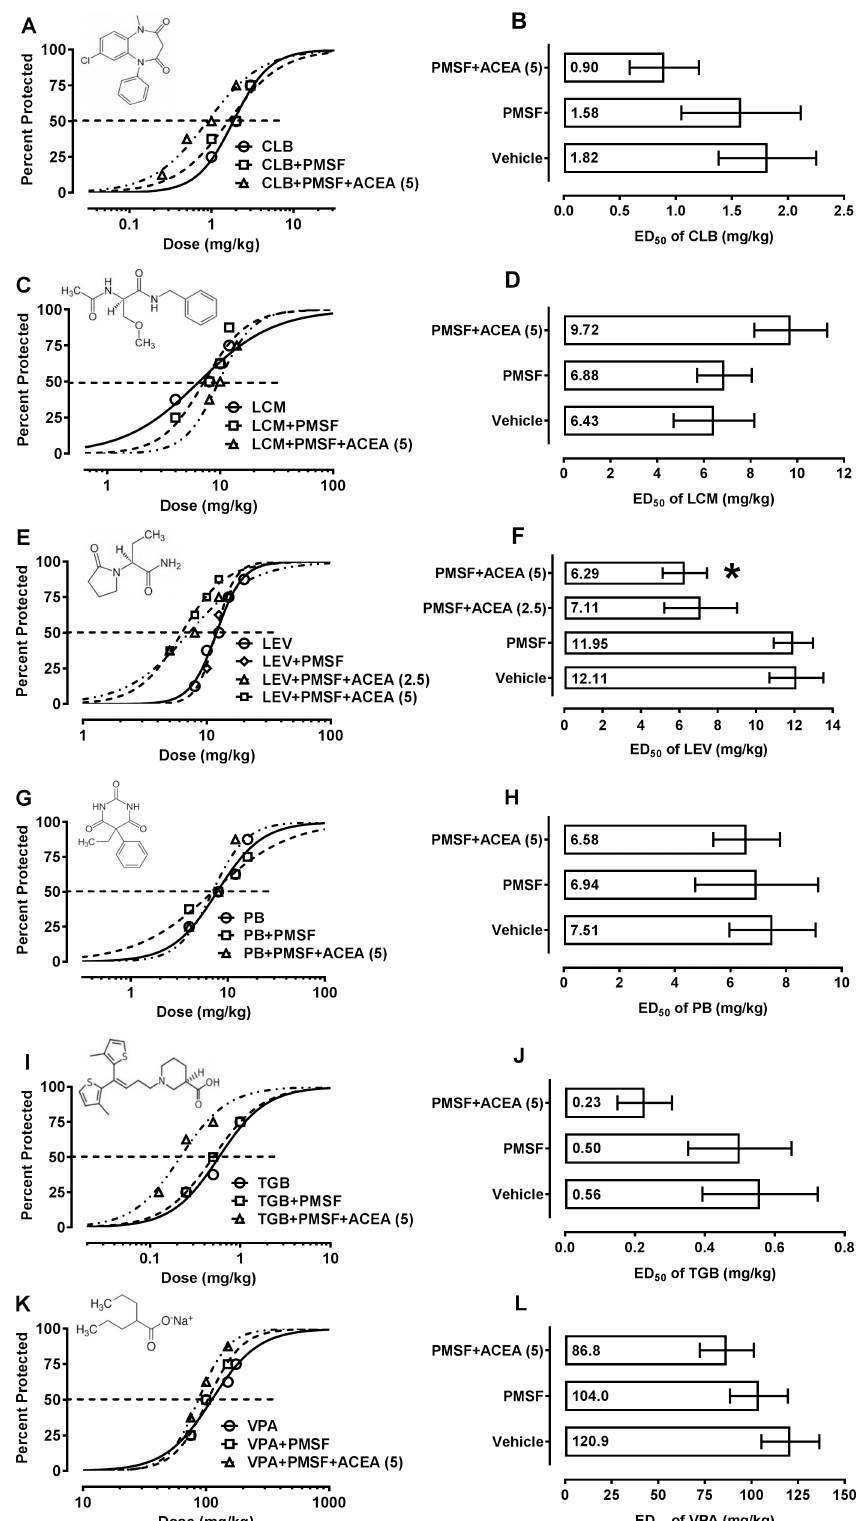
Fig 1. A-L. Influence of ACEA, PMSF and their combination on the anticonvulsant activity of clobazam (CLB), lacosamide (LCM), levetiracetam (LEV), phenobarbital (PB), tiagabine (TGB) and